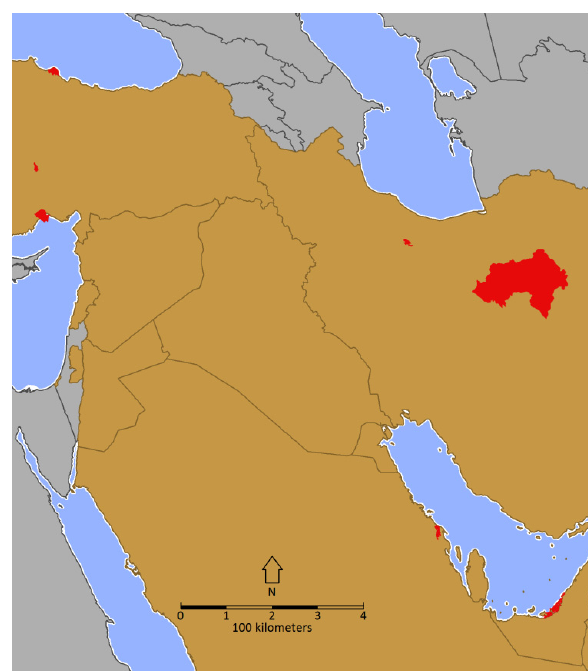
Figure 4. Location of high-loss wetlands, indicated in